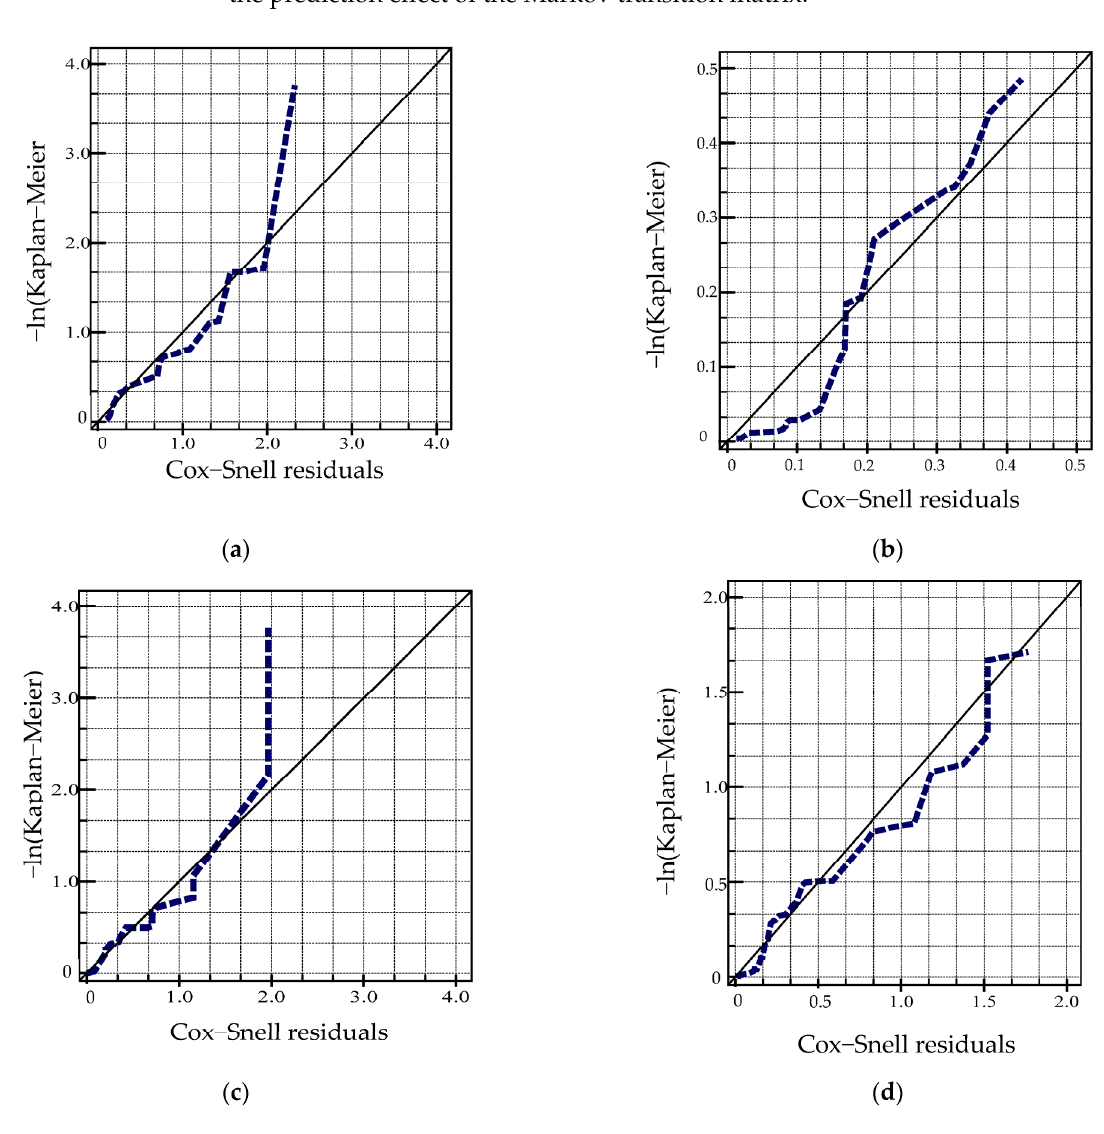
Figure 3. Residuals for the model of state duration. ( a ) State 1; ( b ) State 2; ( c ) State 3; ( d ) State 4.